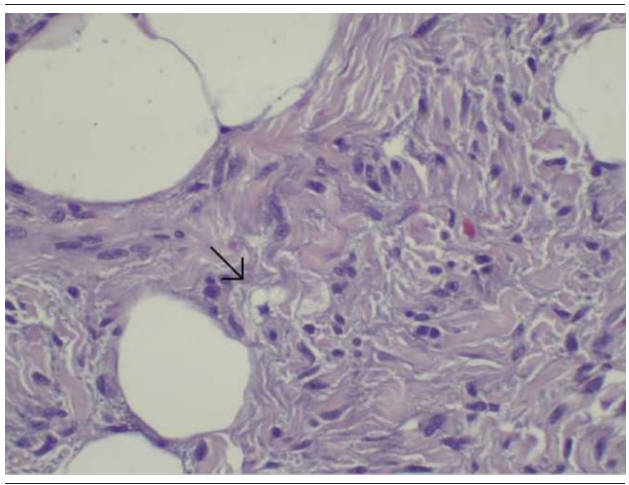
FIGURE 3 – Optical microscopy of the tumoral lesion The arrow indicates an atypical